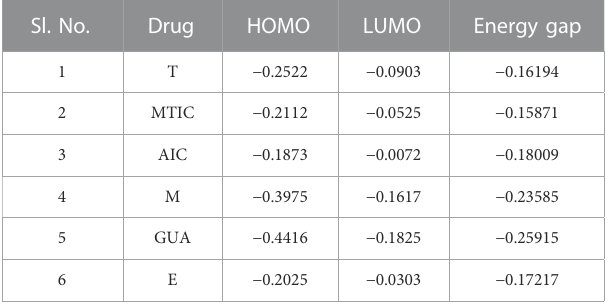
TABLE 3 Highest and lowest occupied molecular orbitals ’ energies Sl.